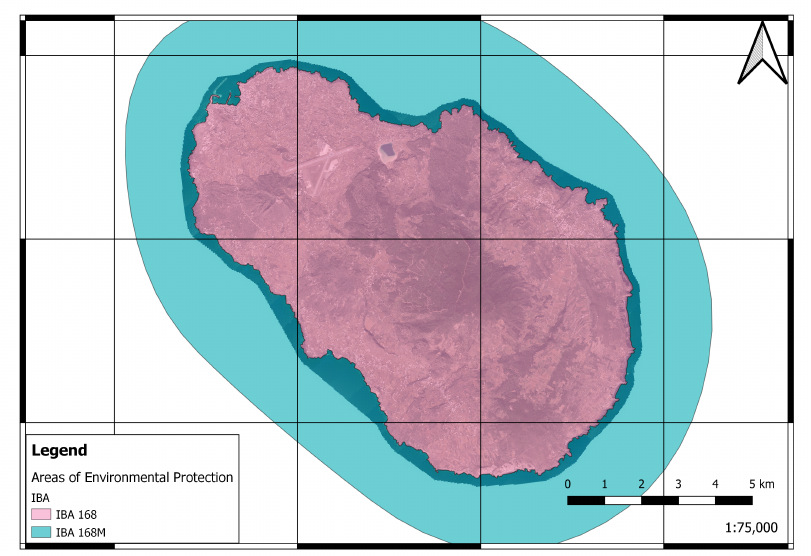
Figure 3. Important Bird